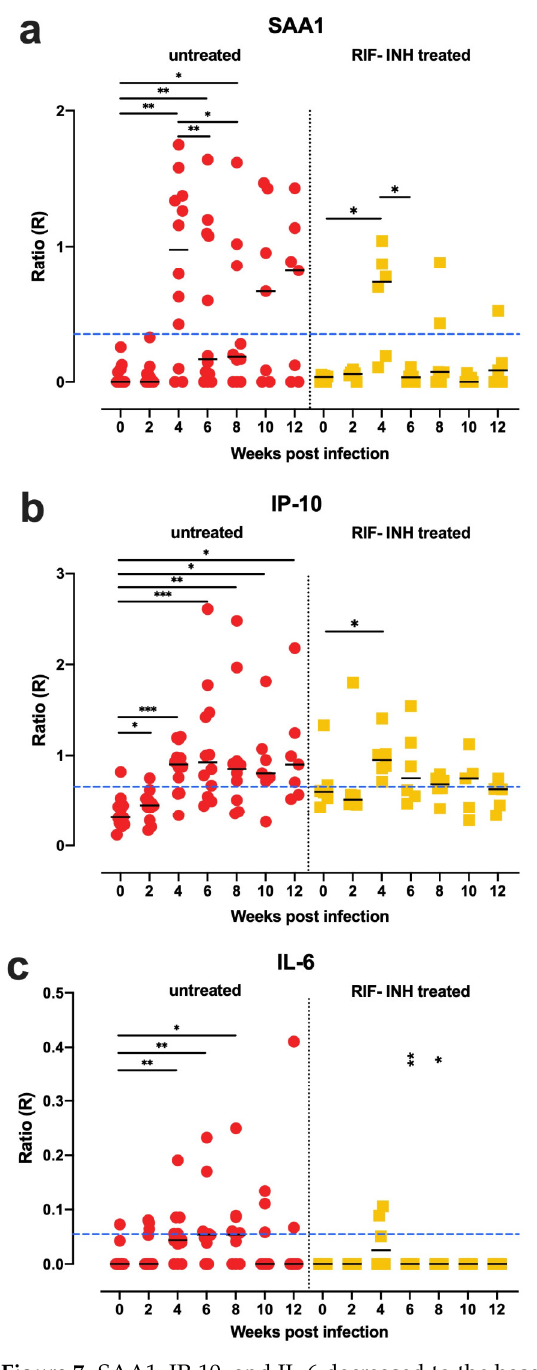
Figure 7. SAA1, IP-10, and IL-6 decreased to the baseline levels upon antibiotic treatment. SAA1, IP-10, and IL-6 levels ( y -axis) were measured by UCP-LFA in serum from low-dose (15 CFU) MTB Erdman infected rhesus macaques ( n = 18), six of them were treated by rifampin (RIF) and isoniazid (INH) from week four postinfection for eight weeks until endpoint at week 12 twelve The median values of each group are indicated by horizontal lines. Red dots indicate untreated macaques; yellow squares indicate RIF + INH treated macaques. Cutoff (blue dashed lines) applied was described in Table 1b. ( a – c ) The SAA1, IP-10, and IL-6 levels were decreased after RIF + INH treatment. Significant differences between each timepoint versus week 0 were determined by Wilcoxon matched-pairs signed rank tests; differences between untreated versus RIF + INH treated at per time point were determined by Mann-Whitney U tests indicated in the right panel (RIF + INH). p -values: * p < 0.05, ** p < 0.01, *** p < 0.001.